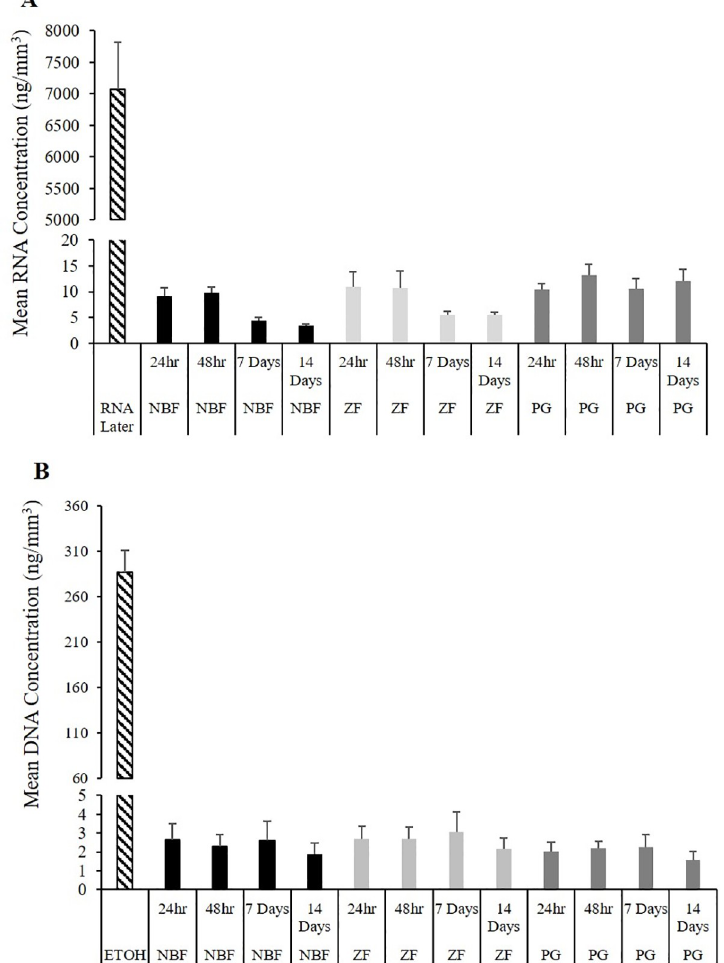
Fig 2. Nucleic acid auantification. (A) Mean (+ standard error) of RNA and (B) DNA concentrations ( μ g/mm 3 ) of microdissected smallmouth bass liver samples fixed in 10% neutral buffered formalin (NBF), Z-Fix 1 (ZF), and PAXgene 1 (PG) for 24 hours, 48 hours, 7 and 14 days. Samples preserved in 95% alcohol (ETOH) and RNALater 1 were included as controls.